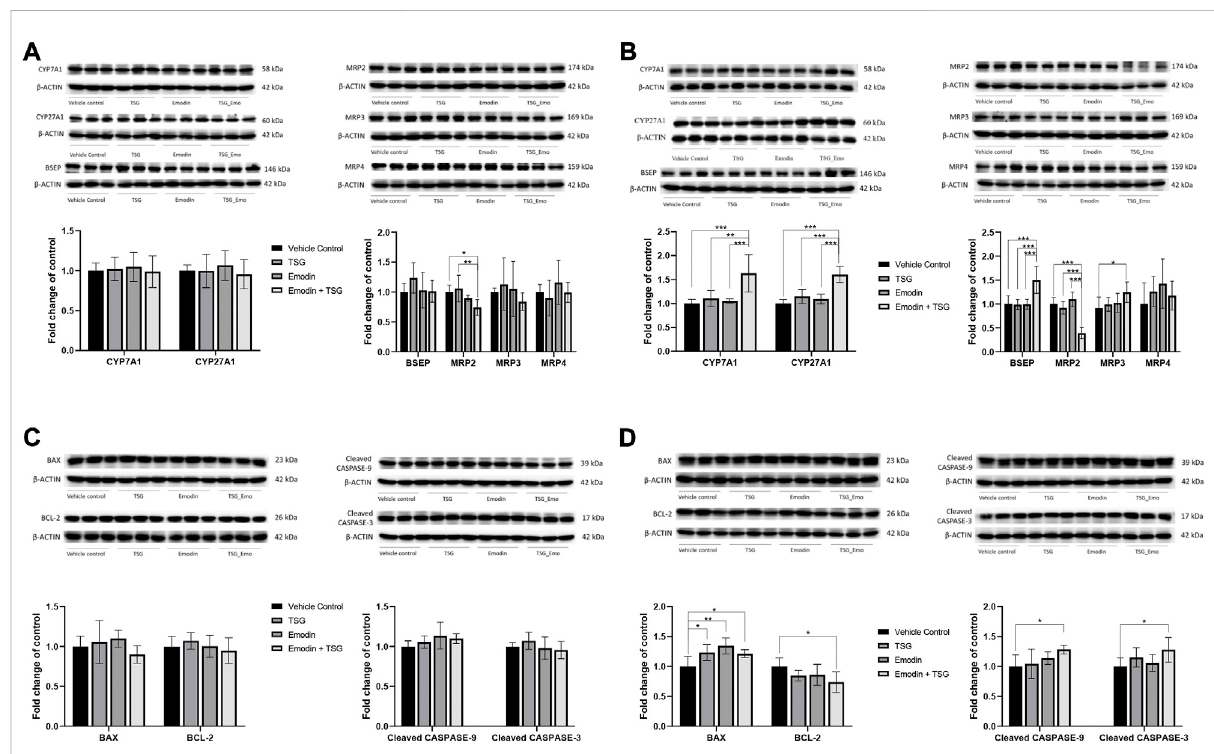
FIGURE 6 Protein expression of bile acid synthesis enzymes (CYP7A1 and CYP27A1), bile acid ef fl ux transporters (BSEP, MRP2, MRP3, and MRP4) and apoptosis-relatedproteins(BAX,BCL-2,CleavedCASPASE-3,andCleavedCASPASE-9)intheliverafteroraladministrationwithemodin,TSGortheir combinationtonormalrats (A,C) orLPS-mediatedin fl ammatorystressmodelrats (B,D) .Thedataareexpressedasmean±SD( n =6).* p < 0.05,** p < 0.01, *** p < 0.001 by two-way ANOVA followed by the Tukey post hoc